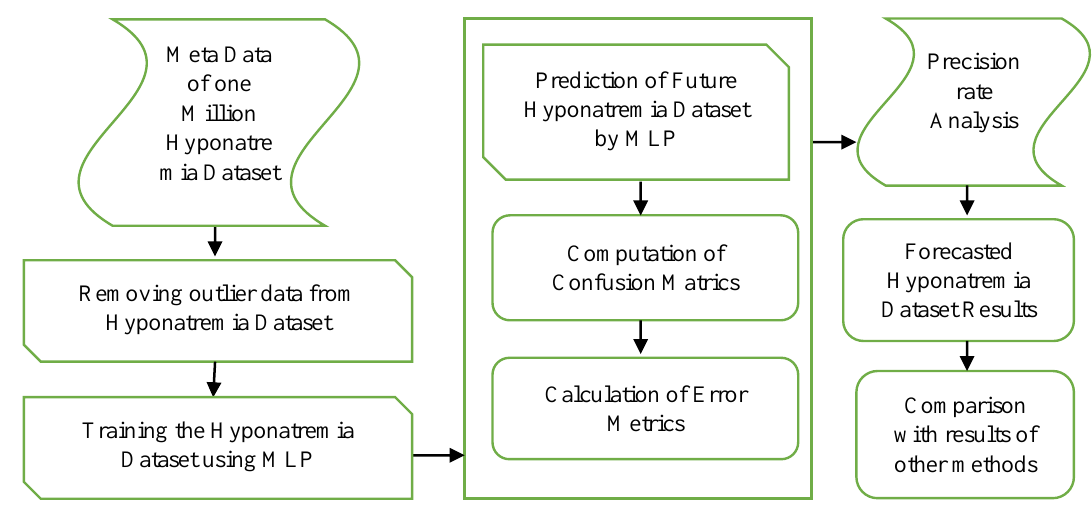
Fig. 1. Block diagram of the proposed